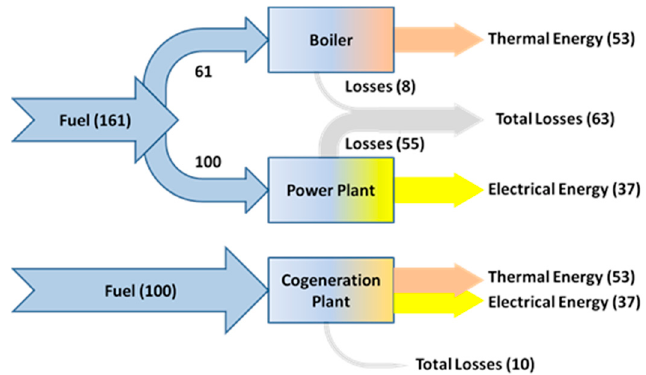
Figure 6. Comparison between the production cycle of a power plant and a cogeneration plant [23].